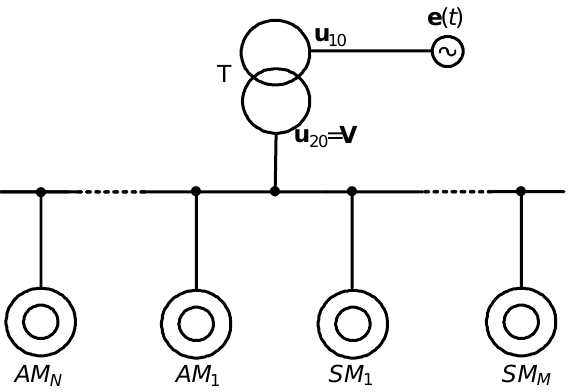
Figure 1. Circuit diagram of the drive system.